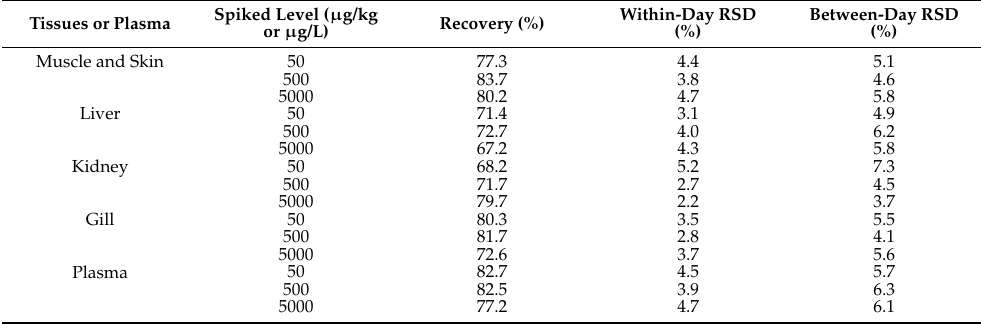
Table 1. Accuracy and precision of the method for doxycycline in fortified muscle and skin, liver, kidney, gill, and plasma samples of yellow catfish ( Pelteobagrus fulvidraco ).